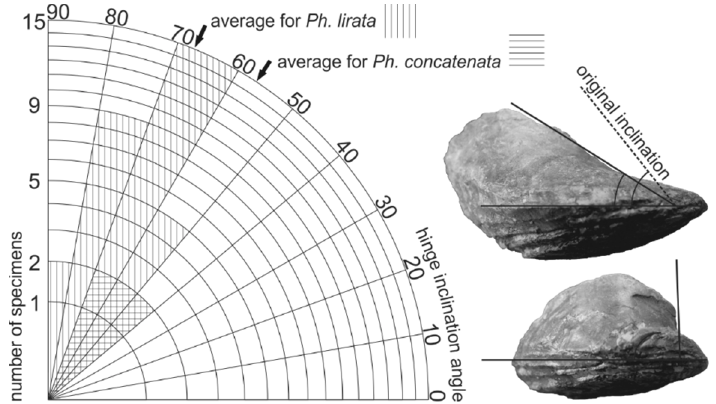
Figure 7. Ventral tilt of the hinge axis in Pholadomya lirata and Ph. concatenata from Middle Bathonian, Cz ę stochowa, with two specimens of Ph. lirata preserved in extreme orientations.